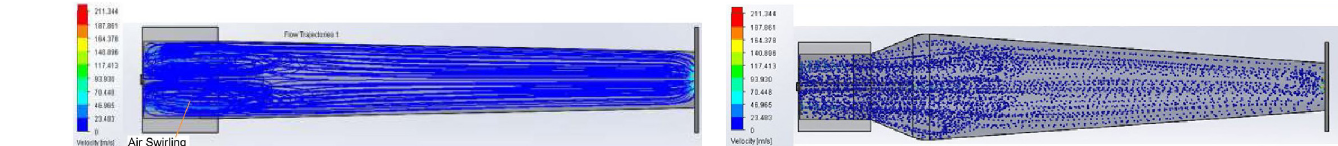
Figure 11. Gas and air velocity profiles in Solidworks Flow